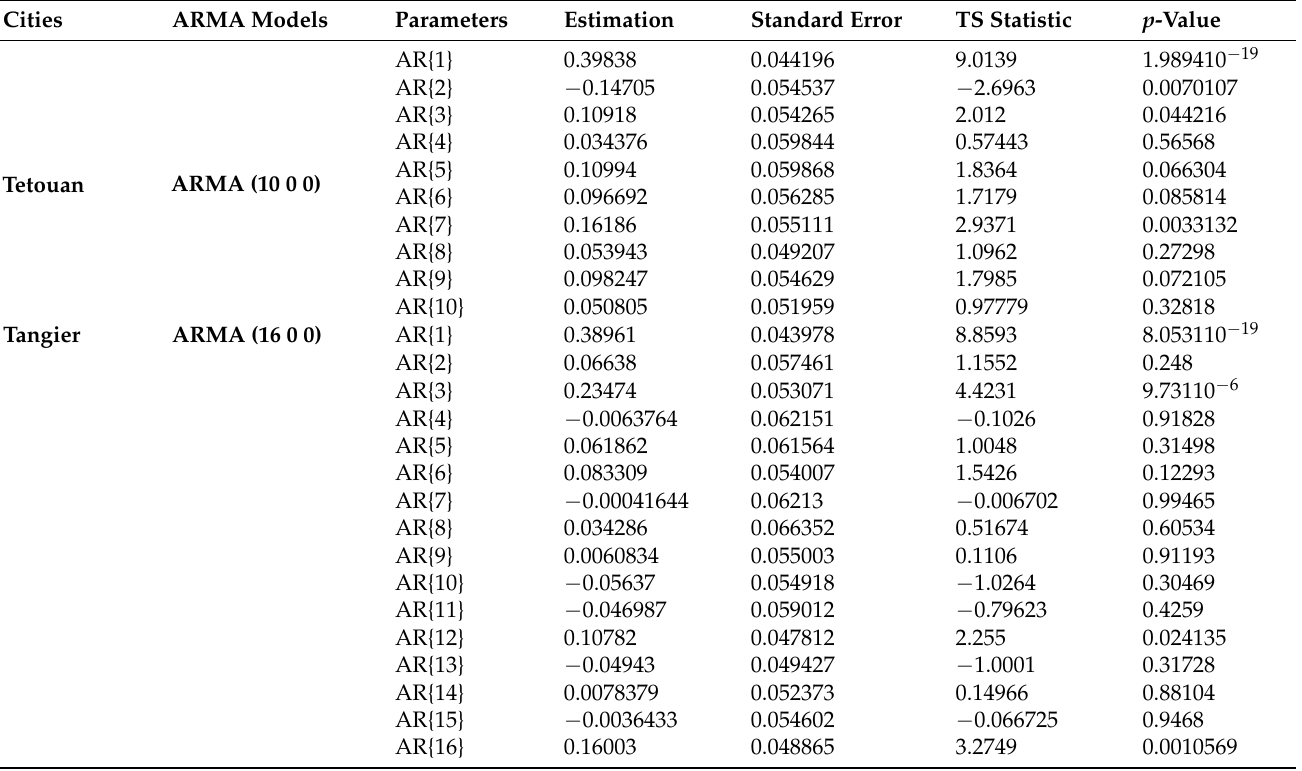
Table 3. Estimation of ARMA model parameters for daily global solar radiation prediction for both cities.